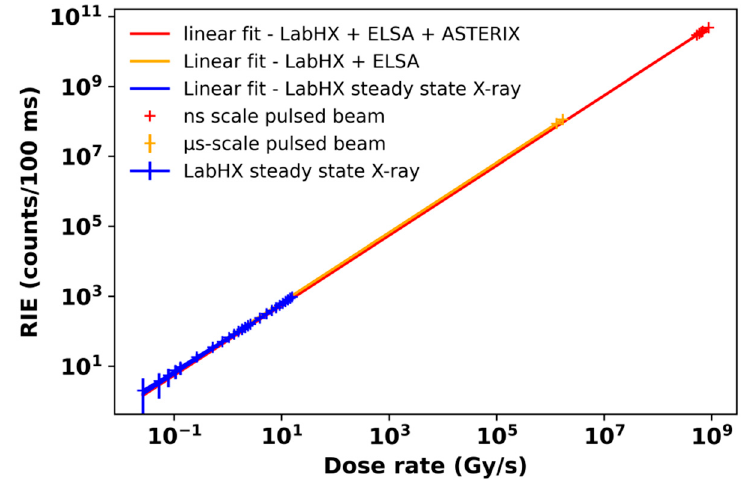
Figure 9. Comparison between the nitrogen-doped optical fiber RIE dose rate dependencies as measured with steady-state 40 keV X-ray source and µs (up to 19 MeV) and ns (~1 MeV) scale pulsed X-ray sources.